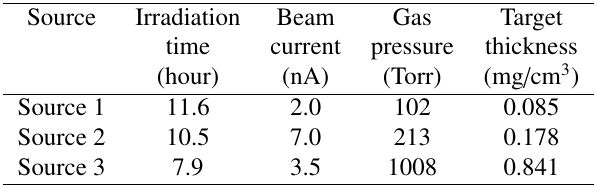
Table 1. Irradiation conditions for each foil.